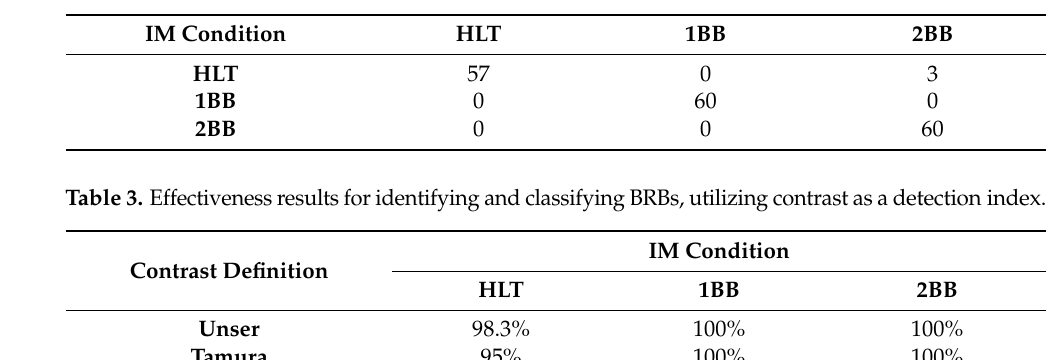
Table 2. Confusion matrix using Tamura contrast definition for BRB detection and classification.